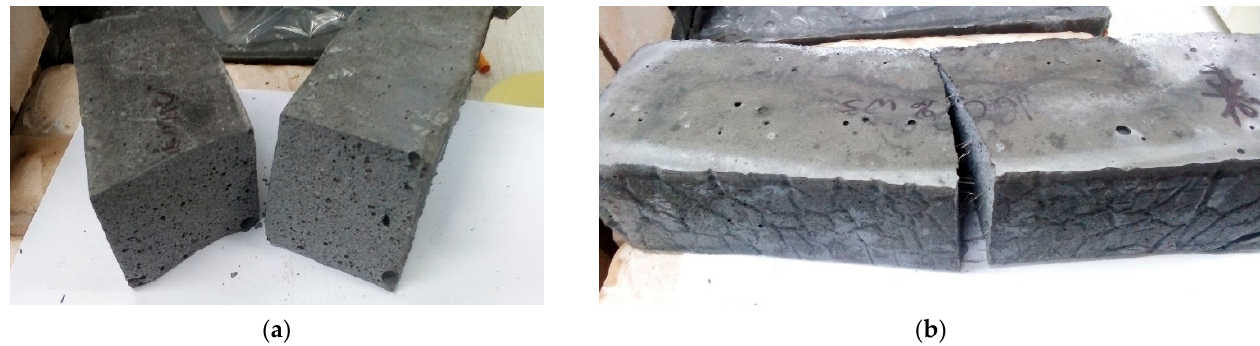
Figure 10. ( a ) An example photo showing the breakthrough of a geopolymeric composite without fibers; ( b ) An example photo showing the breakthrough of a geopolymeric composite reinforced with steel fibers.